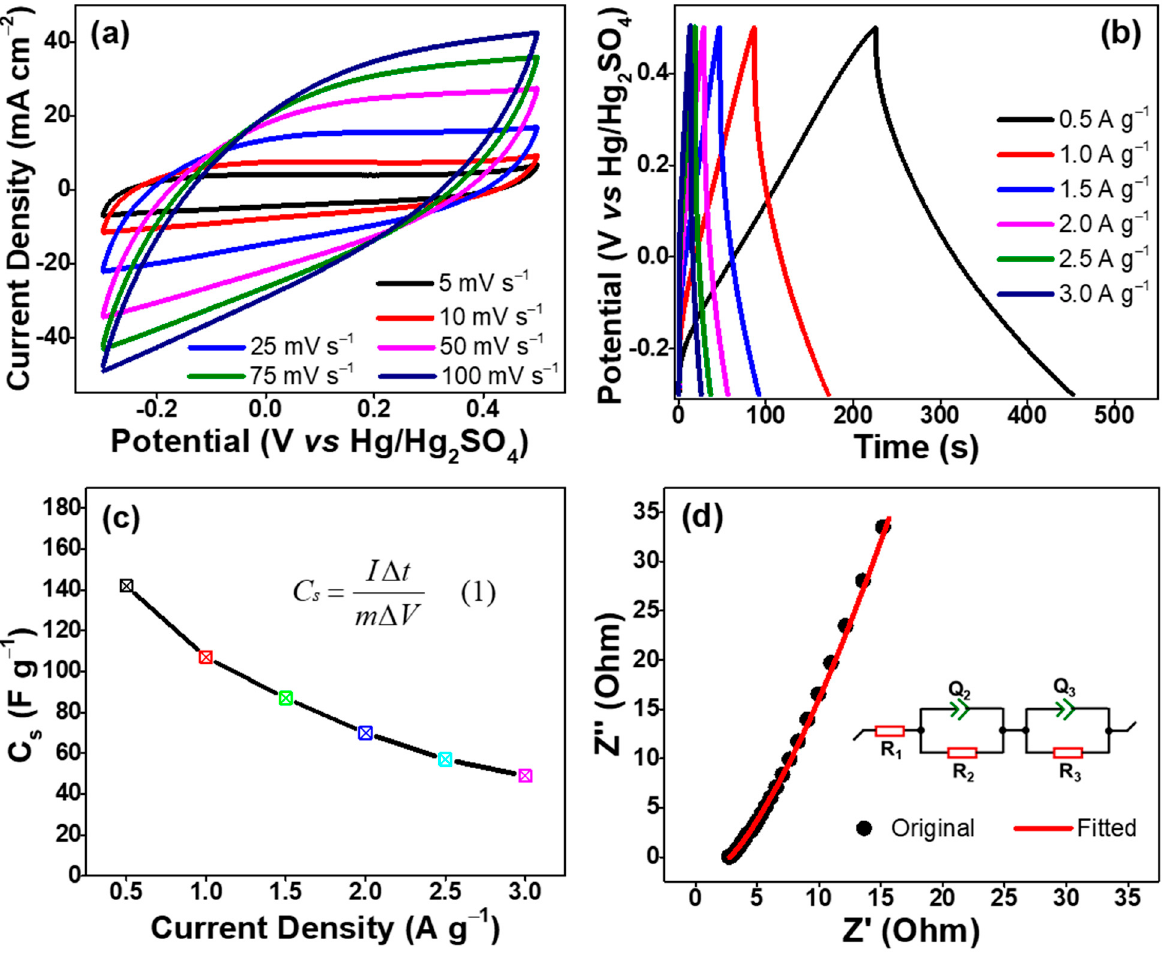
Figure 6. Electrochemical performance of ATC: ( a ) CV curves, ( b ) GCD curves, ( c ) C s at various current densities (inset: equation for the calculation of specific capacitances (C s )), and ( d ) Nyquist plot with suitable circuit diagram.